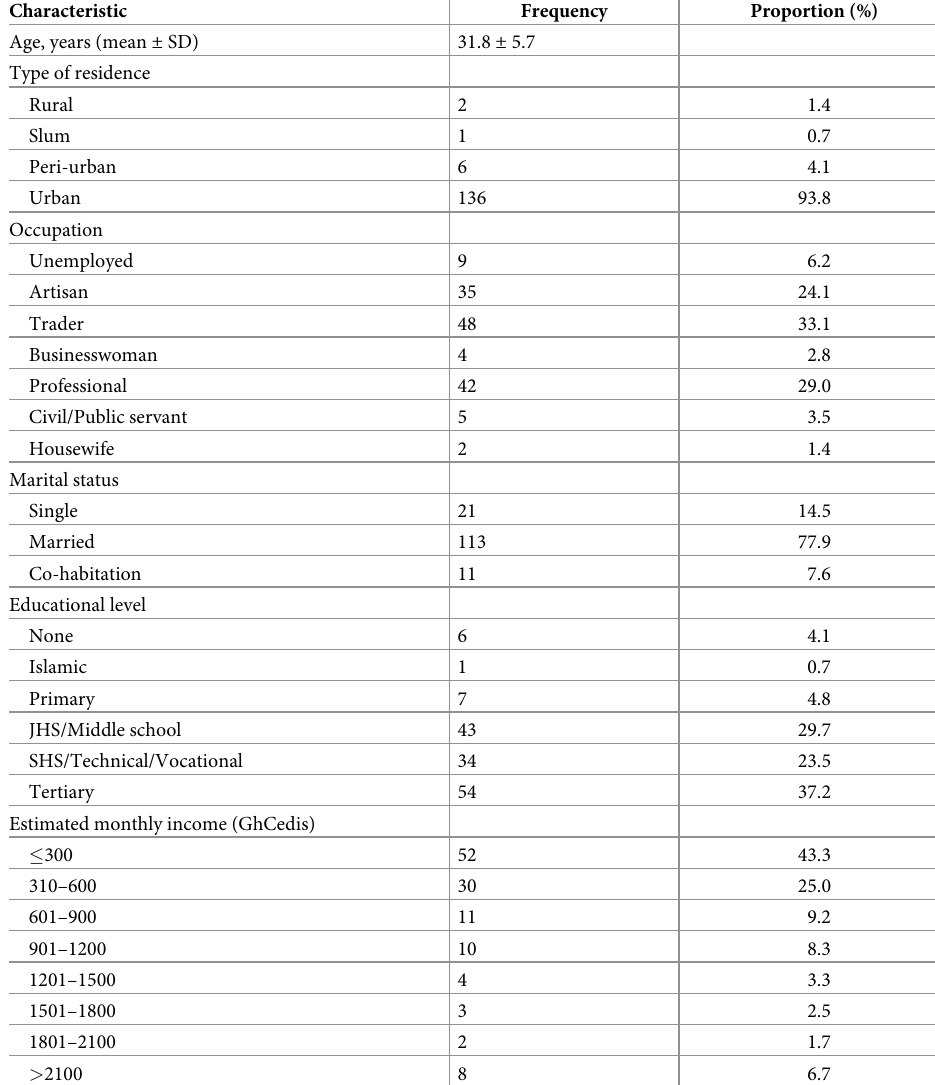
Table 1. Socio-demographic characteristics of study